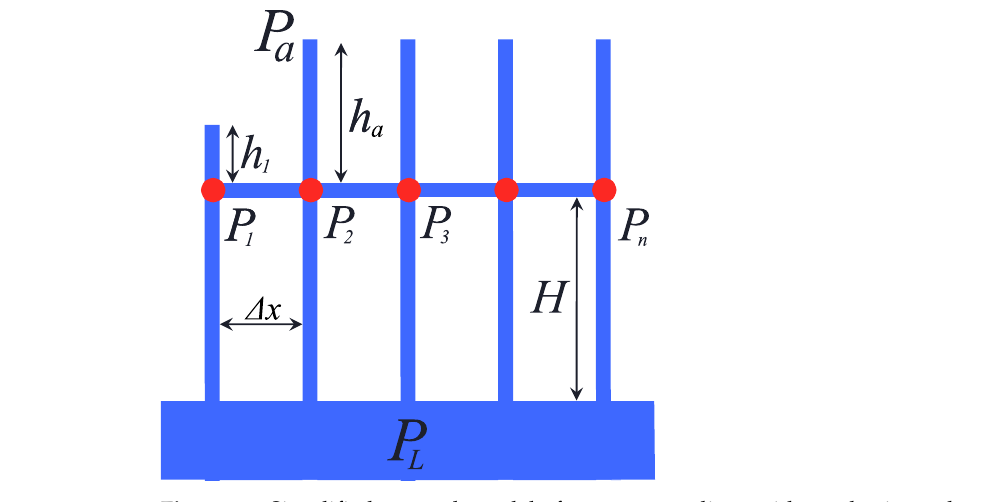
Figure 11. Simplified network model of a porous medium with one horizontal capillar layer. The parts of the channels filled with liquid are marked with a thick